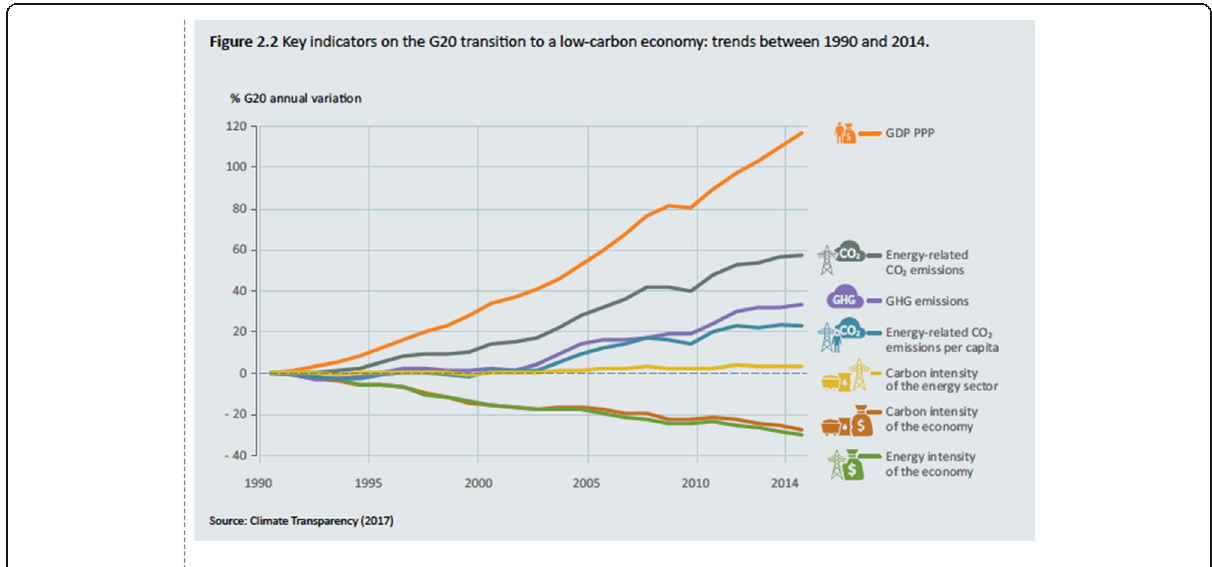
Fig. 3 Decoupling impact from economic growth in the G20. Source Climate Transparency (2017)